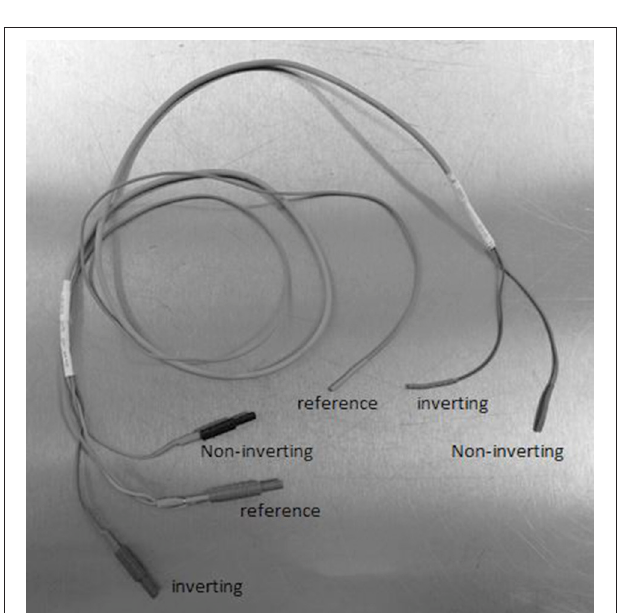
FIGURE 3 | The electric auditory brainstem responses (EABR) obtained from an ear with auditory neuropathy due to perinatal asphyxia.